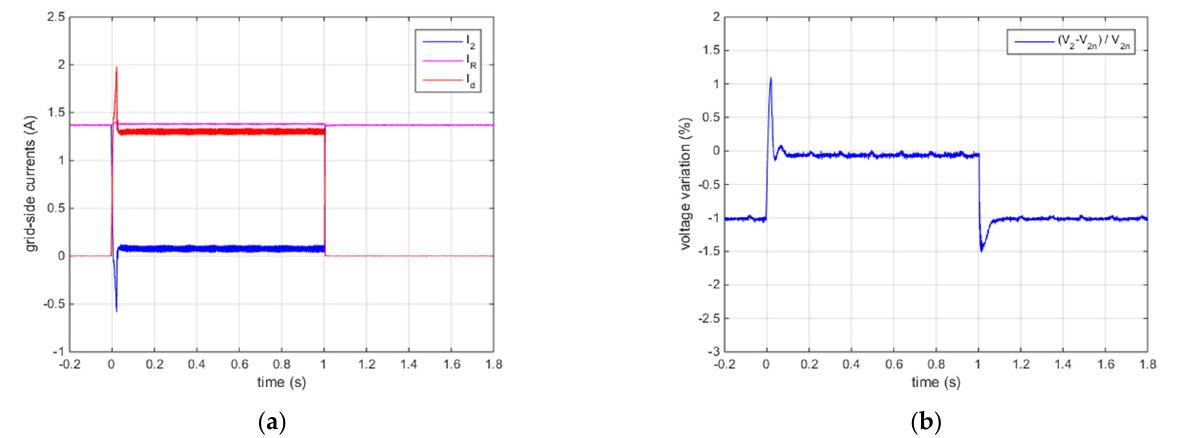
Figure 11. Experimental results in scenario #2 (SD − GN): ( a ) grid − side currents; ( b ) percentage variation of microgrid voltage.